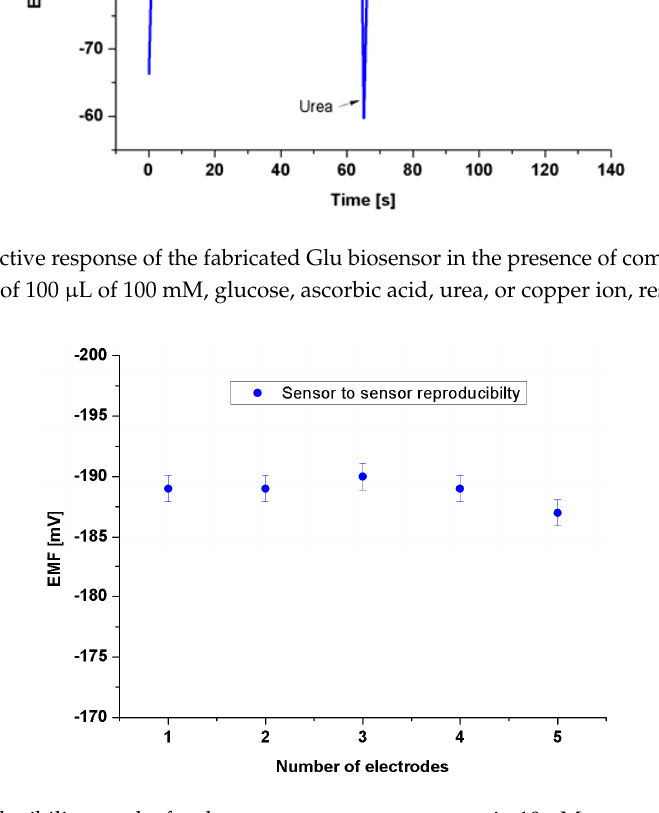
Figure 10. Reproducibility results for the sensor to sensor response in 10 μ M concentration of Glu for five sensor electrodes using the same set of conditions and the same functionalized membrane.